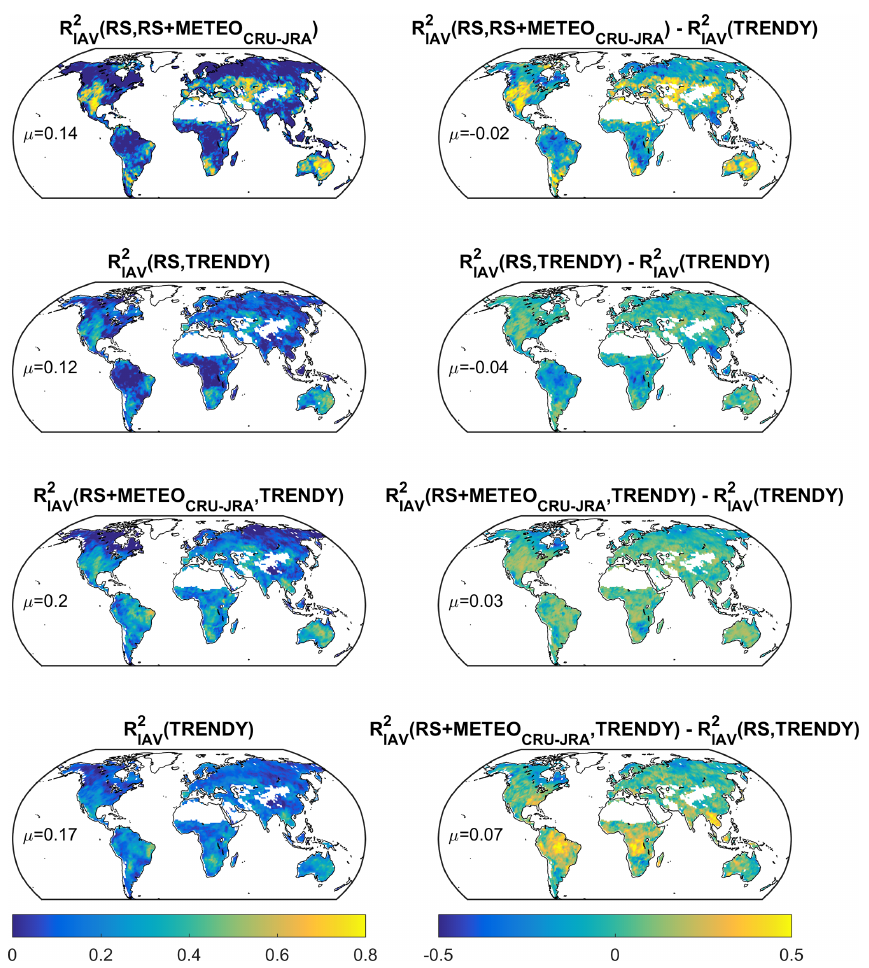
Figure 9. Consistency between interannual variabilities (IAV) of local NEE from FLUXCOM setups and TRENDY for the period 2001–